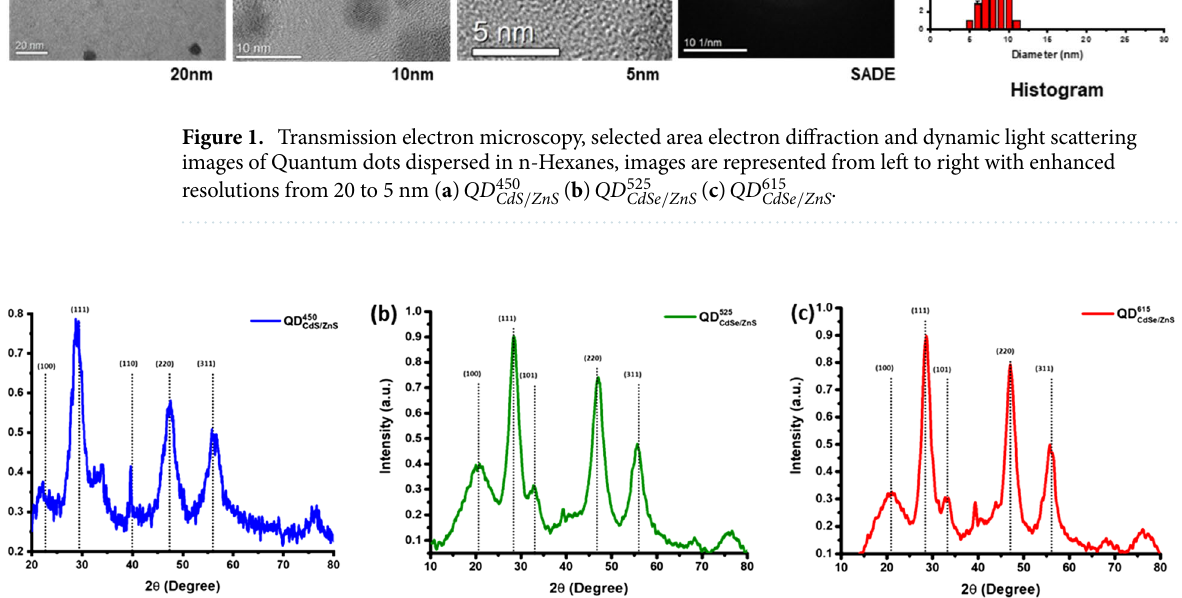
Figure 2. X-ray diffraction spectrum of the quantum dots in powder form ( a ) QD QD 615 CdSe / ZnS